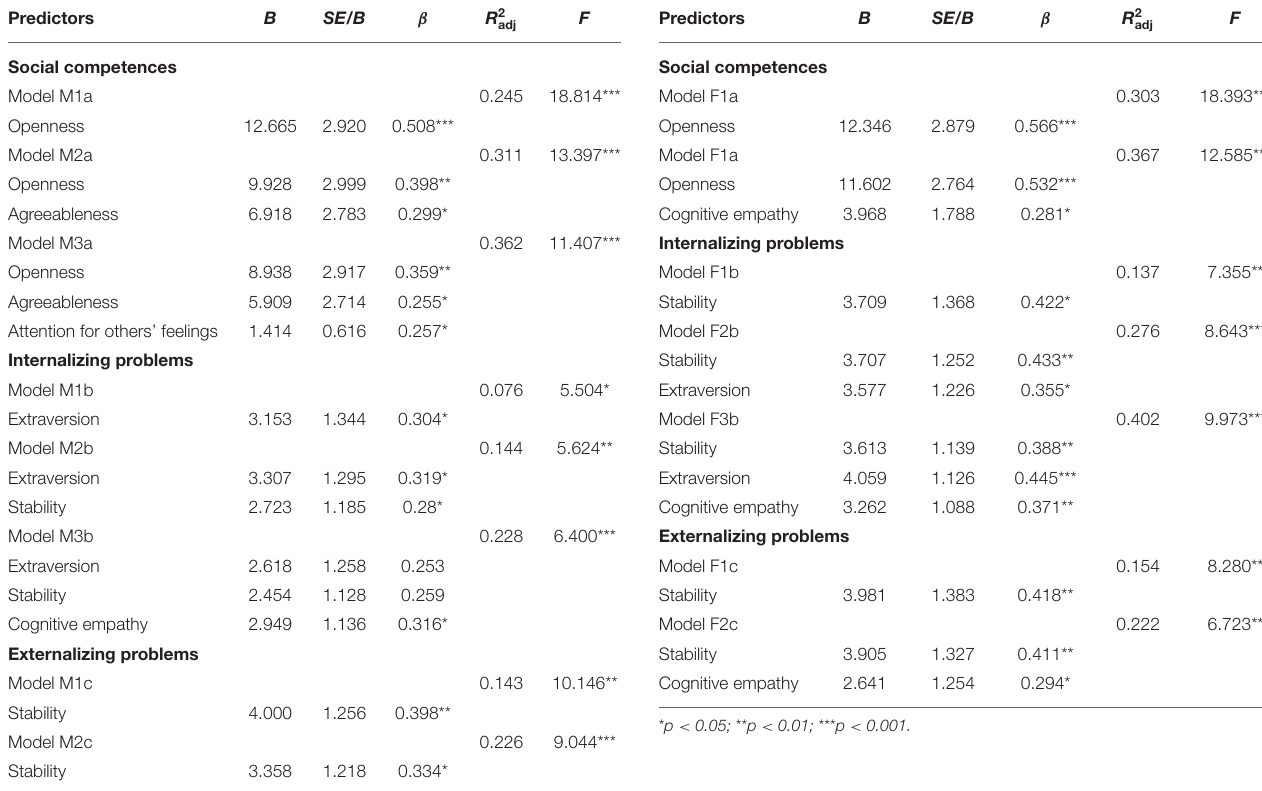
TABLE 8 | Predictors of children’s social skills according to children’s individual characteristics and their skills in empathy as perceived by fathers.